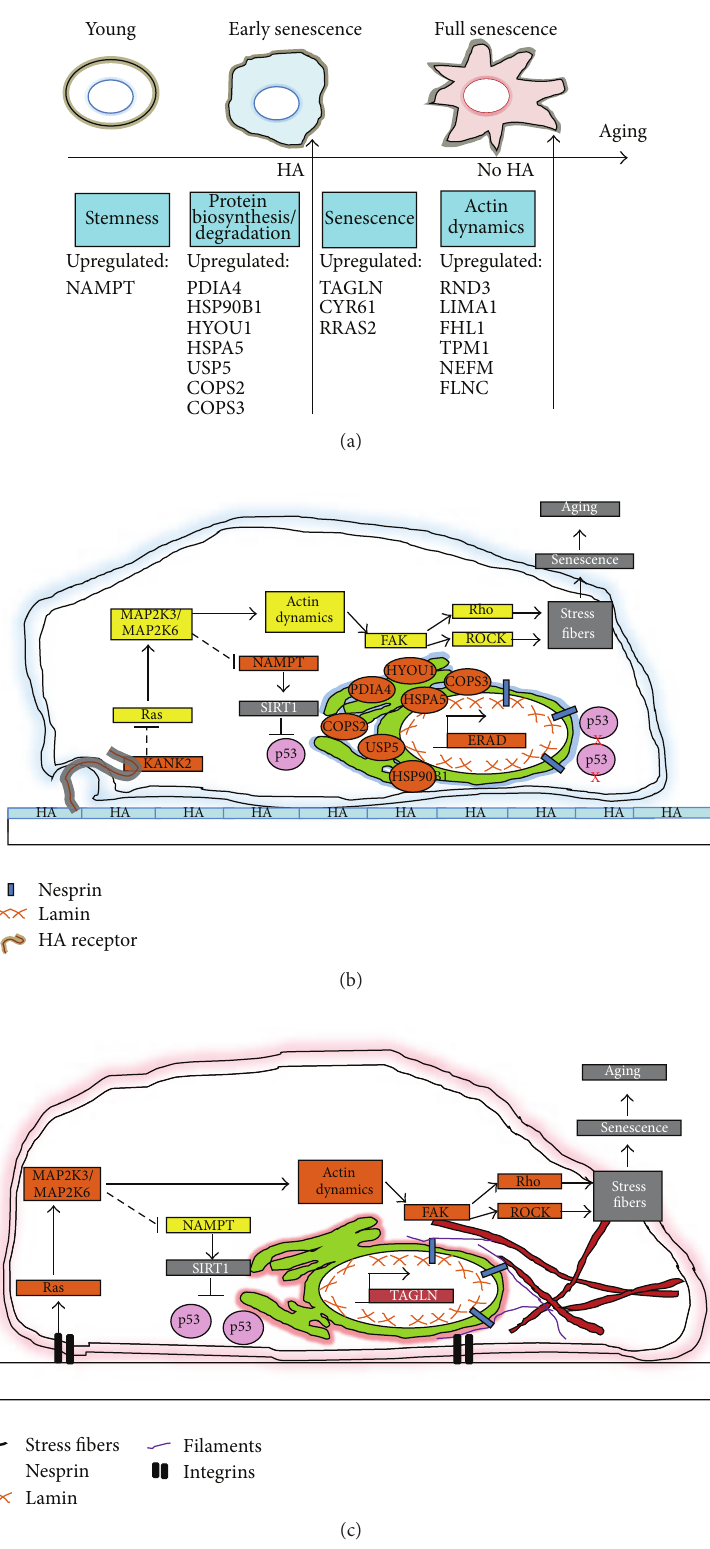
Figure 5: PDMSC underwent normal aging process without HA presence. (a) The aging phenomenon of PDMSC was hypothesized to be attenuated under HA presence. (b) HA was hypothesized to bind to its receptor with ankyrin repeat domain (KANK2) and suppressed the downstream actin-interacting proteins. (c) In absence of HA, the Ras signaling was hypothesized to have increased over long period of expansion and increased the downstream actin dynamics, focal adhesion kinase (FAK), stress fiber formation, and enhanced aging. Yellow boxes represented downregulation; orange boxes represented